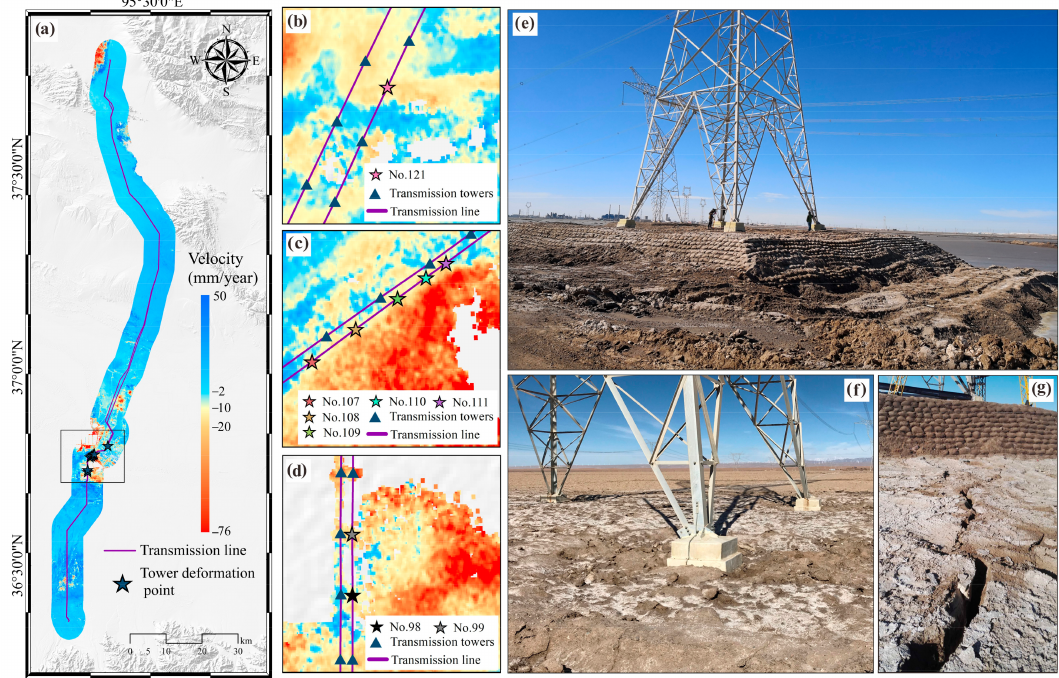
Figure 5. ( a ) Average vertical deformation map along UHV transmission line; ( b – d ) zoom- in of vertical deformation map of typical transmission towers; ( e – g ) field deformation of the transmission